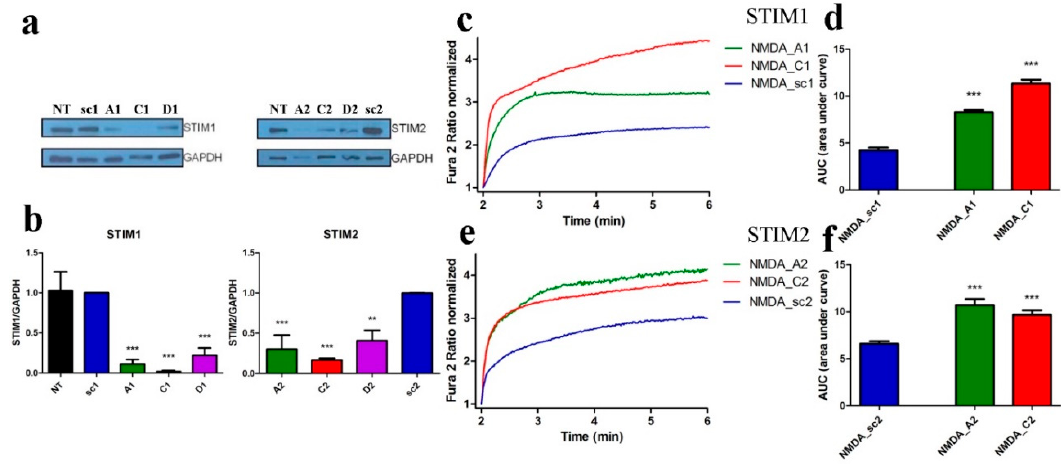
Figure 3. shSTIM1 and shSTIM2 increase NMDA-induced Ca 2+ responses. ( a ) Western blot analysis